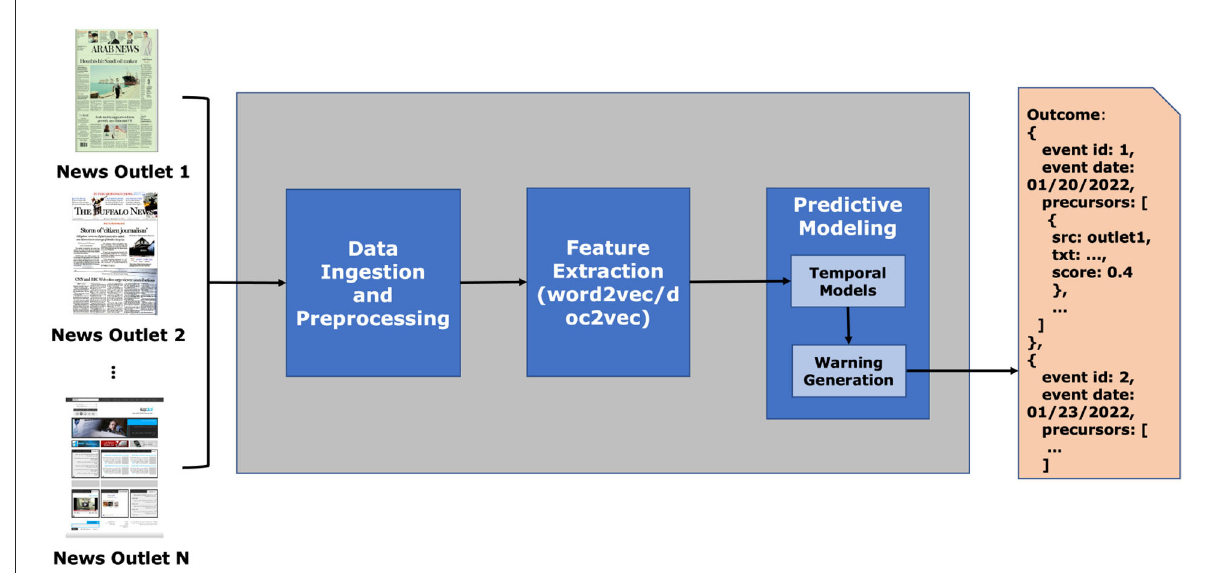
FIGURE1 A framework for anticipating geopolitical events with